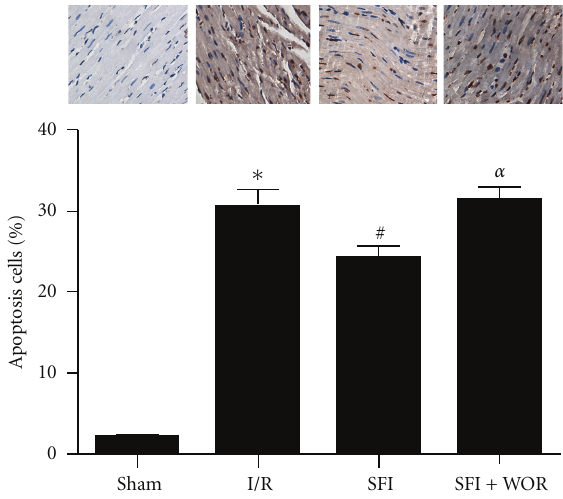
Figure 4: Representative photomicrographs of TUNEL staining from Sham, I/R, SFI, and SFI+WOR groups, respectively ( × 400). I/R: ischemia/reperfusion; SFI: Shen-fu injection; WOR: wortman- nin. Values presented are mean ± SEM. n = 4, ∗ P < . 05 versus Sham, # P < . 05 versus I/R, and α P < . 05 versus